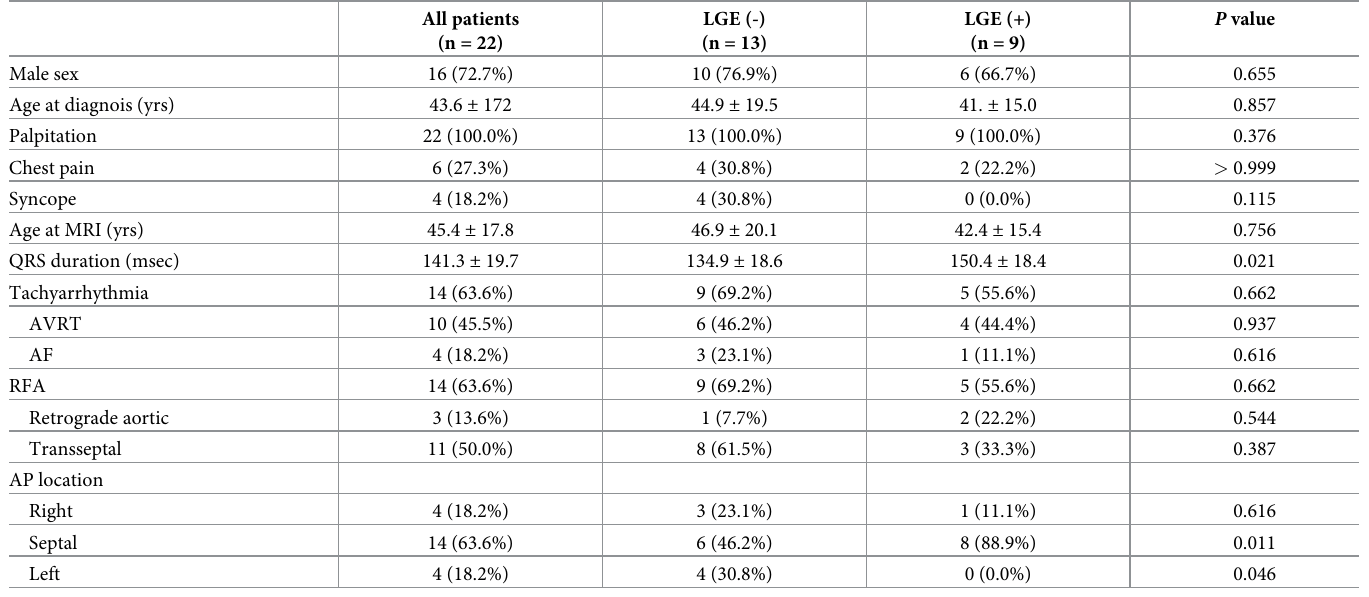
Table 1. Comparison of clinical characteristics according to the presence of LGE.